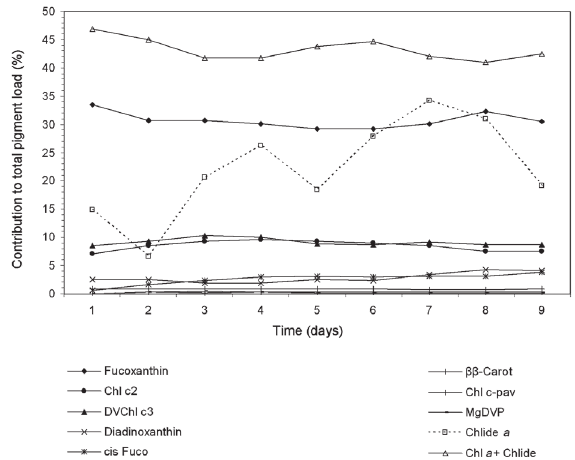
Fig . 5. – temporal variations in the relative contributions of ac- cessory compounds to the total pigment content observed during growth of P. delicatissima in L1